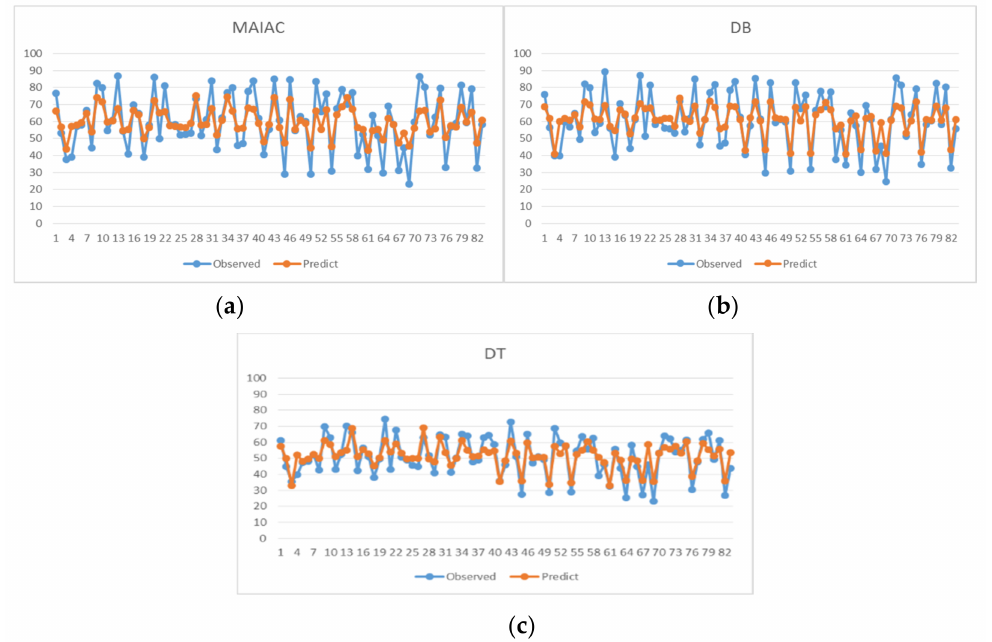
Figure 9. Comparison of annual mean of satellite predicted (Predict) and matched observed (Observed) PM 2.5 in the 83 sites from MAIAC ( a ), DB ( b ), DT( c ) AOD, respectively. The dotted lines here are used to show site-by-site variations of predicted PM 2.5 bias.